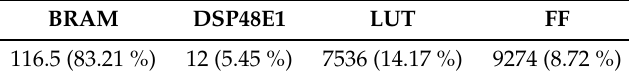
Table 2. Hardware utilization of 1-level DWT module.